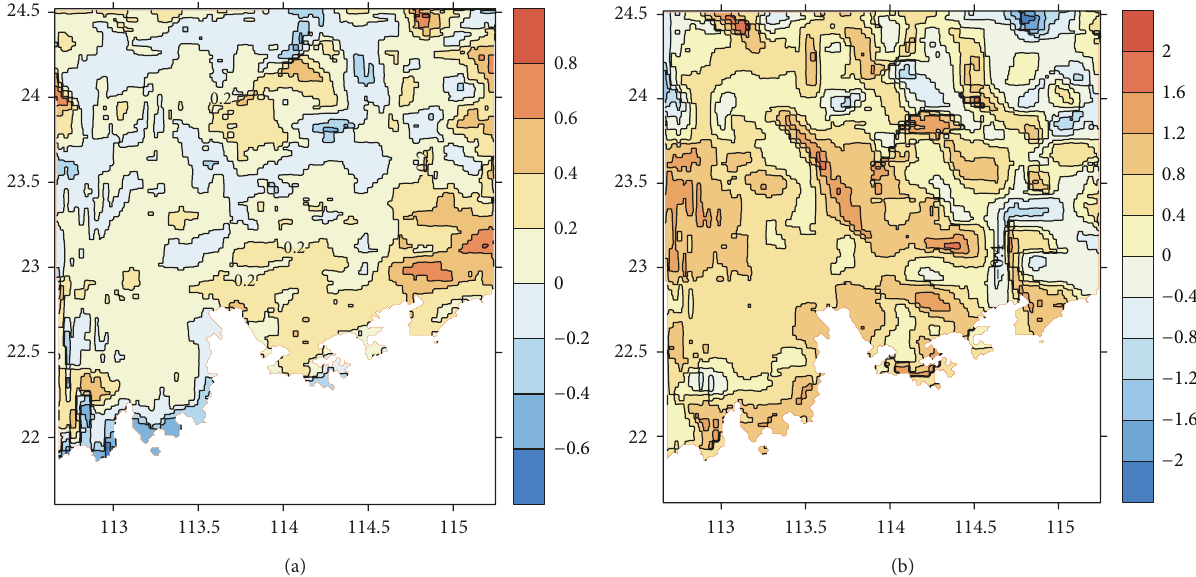
Figure 7: Annual variation of the ground heat flux in JJA and DJF from the year 2000 to the year 2020. The unit is W ⋅ m −2 . (a) JJA; (b) DJF.